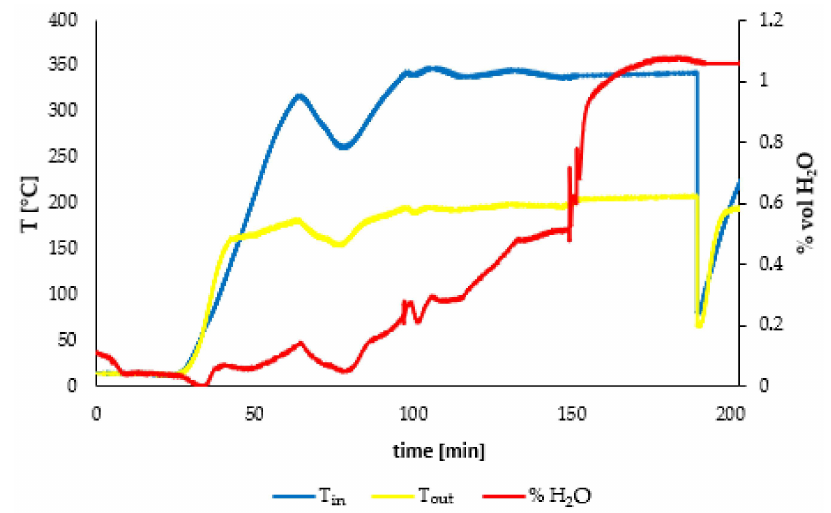
Figure 7. Water and temperatures trend–first wet test (with O 2